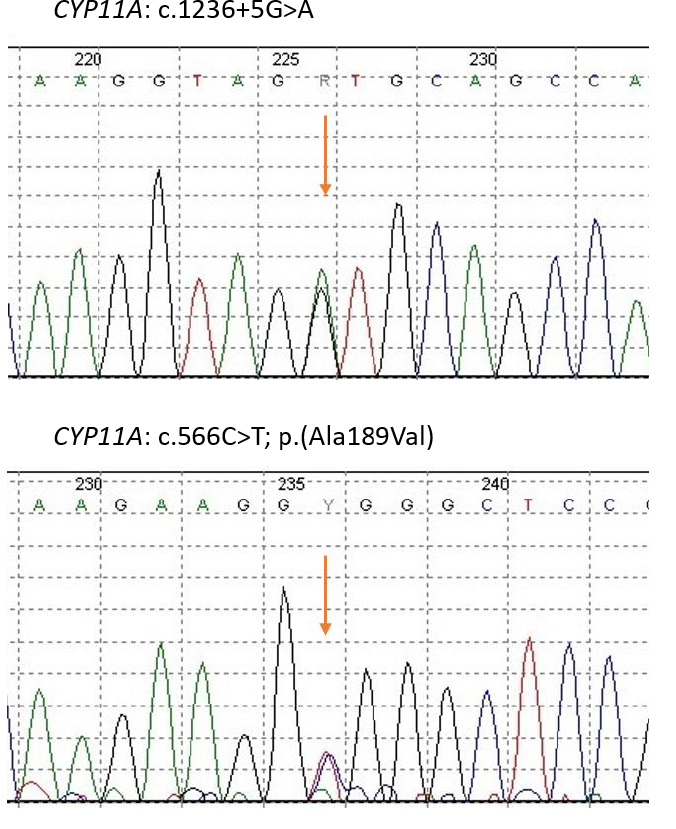
Figure 3. Results of automated DNA sequencing for CYP11A1 splice site mutation NM_000781.2 c.1236 + 5G > A (upper chromatogram) and missense mutation NM_000781.2 c.566C > T; p.(Ala189Val) (bottom chromatogram) .